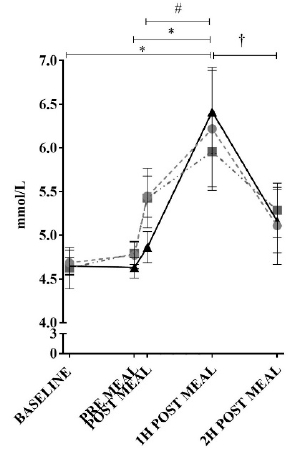
Figure 4. Blood glucose responses to ingestion of test meals. ● = control meal, high-LA. Measured in plasma using an auto-calibrating automated sampler. * = p < 0.05 all meals